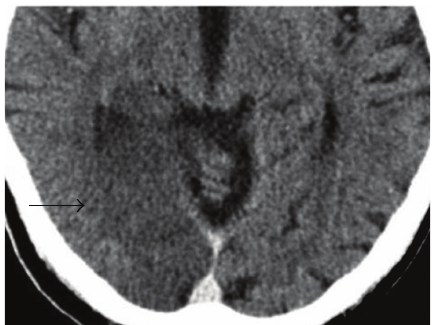
Figure 3: Contrast-enhanced cranial computed tomographic scan showing an insult of the right posterior region with hypodensity of the parafalcine parenchyma as well as loss of grey/white matter differentiation (black arrow).